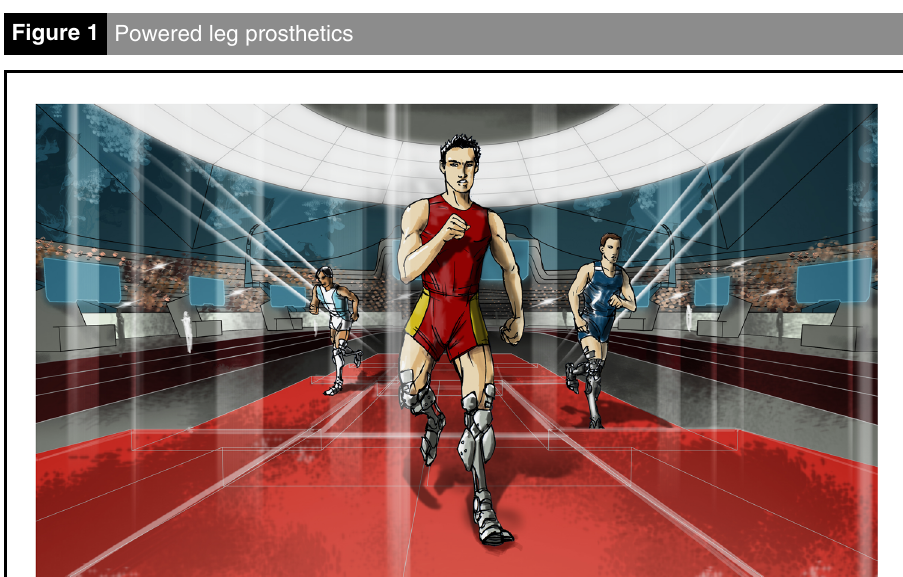
Figure 1 Powered leg